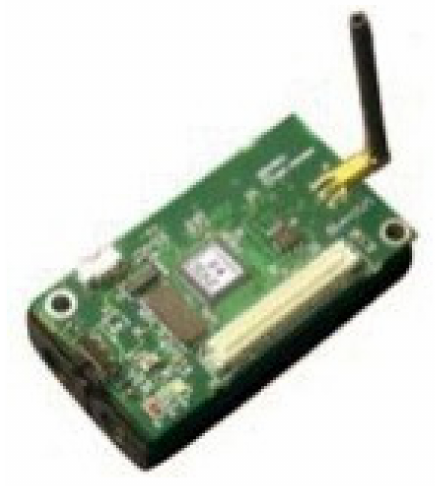
Figure 11. Mica2 Mote sensor